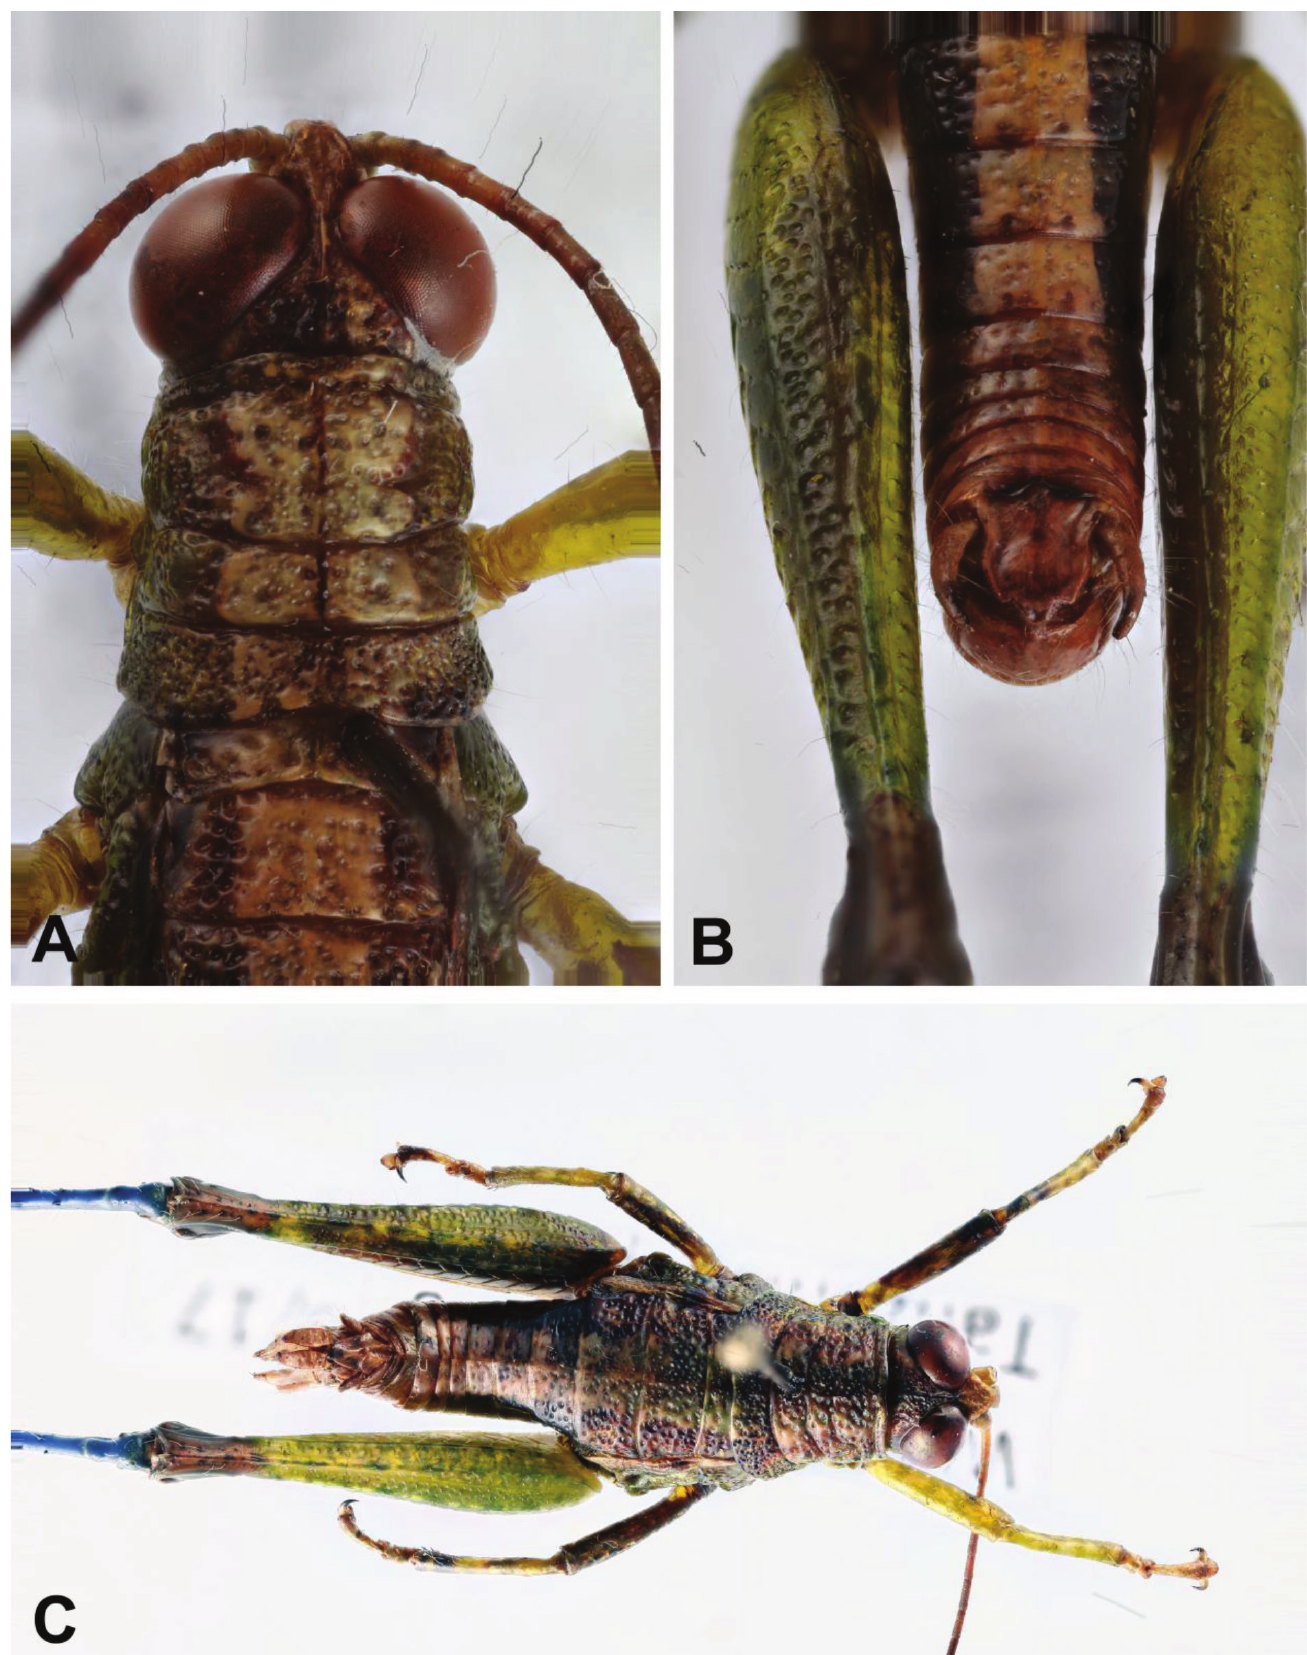
Fig. 2. Details of Physocrobylus venetus sp. nov. A. Male, head, dorsal view; B. Abdomen, dorsal view; and C. Female, dorsal